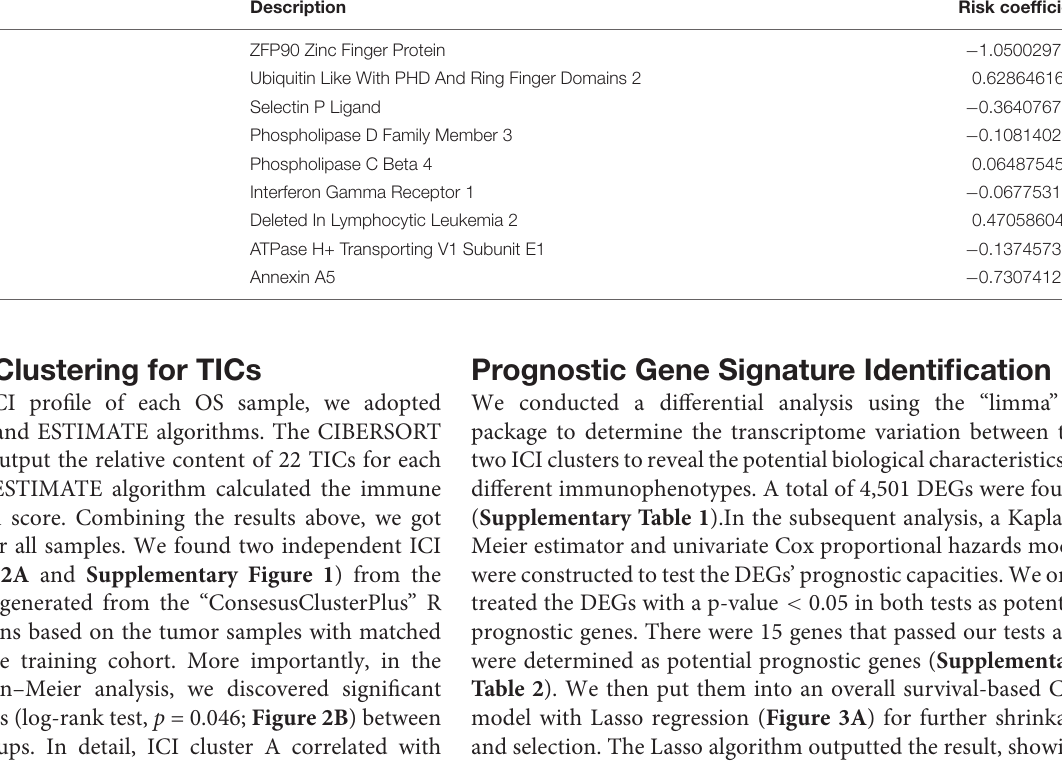
FIGURE 2 | Consensus clustering for tumor-infiltrating immune cells. (A) Two ICI clusters were generated from unsupervised clustering of the ICI profile data of the training cohort. Rows represent ICI types, and columns represent OS samples. (B) Overall survival-based Kaplan–Meier estimator of two ICI clusters in the training cohort. The log-rank test showed an overall p = 0.046. ICI, immune cell infiltration; OS, osteosarcoma. TABLE 2 | Prognostic genes obtained from the LASSO Cox regression model. Gene